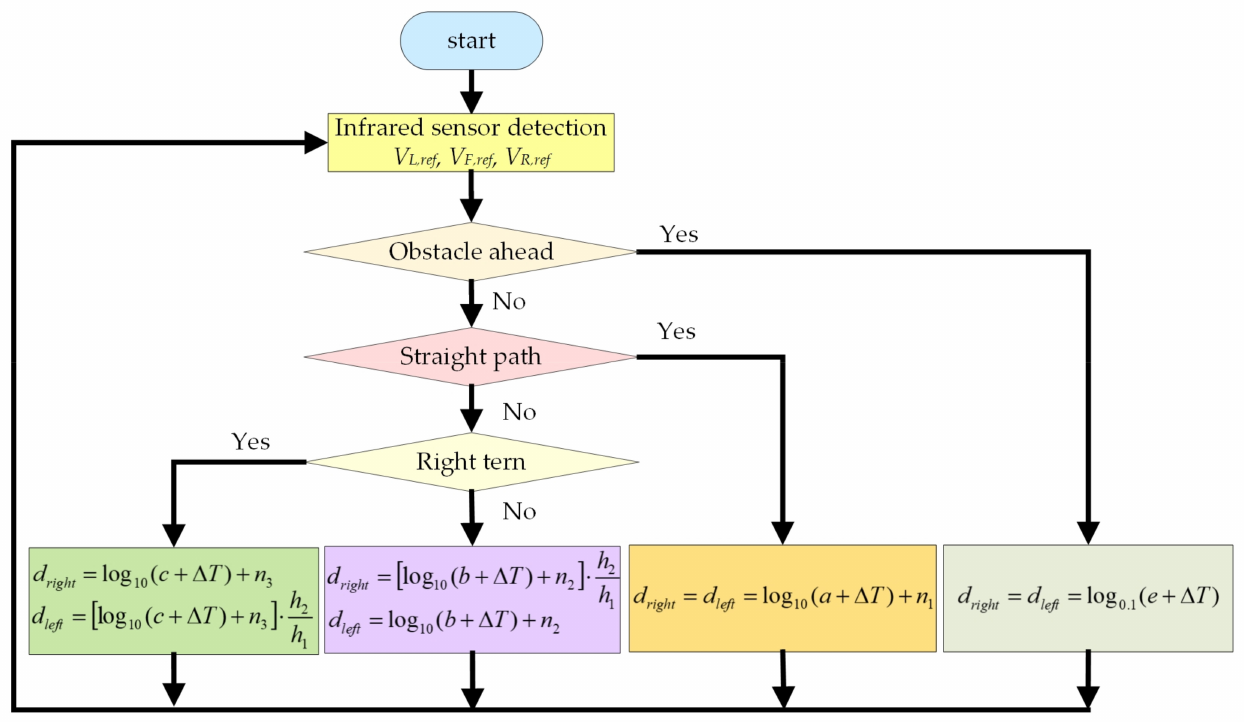
Figure 9. Flowchart of the proposed LCOT control